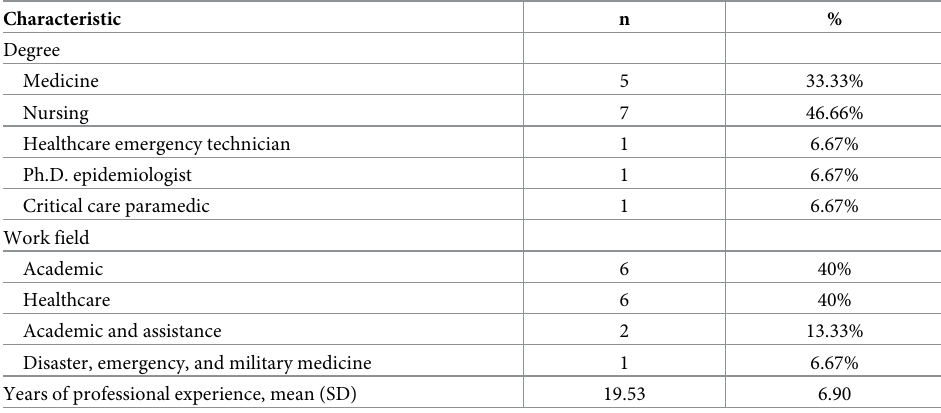
Table 1. Demographic characteristics of the experts (N =